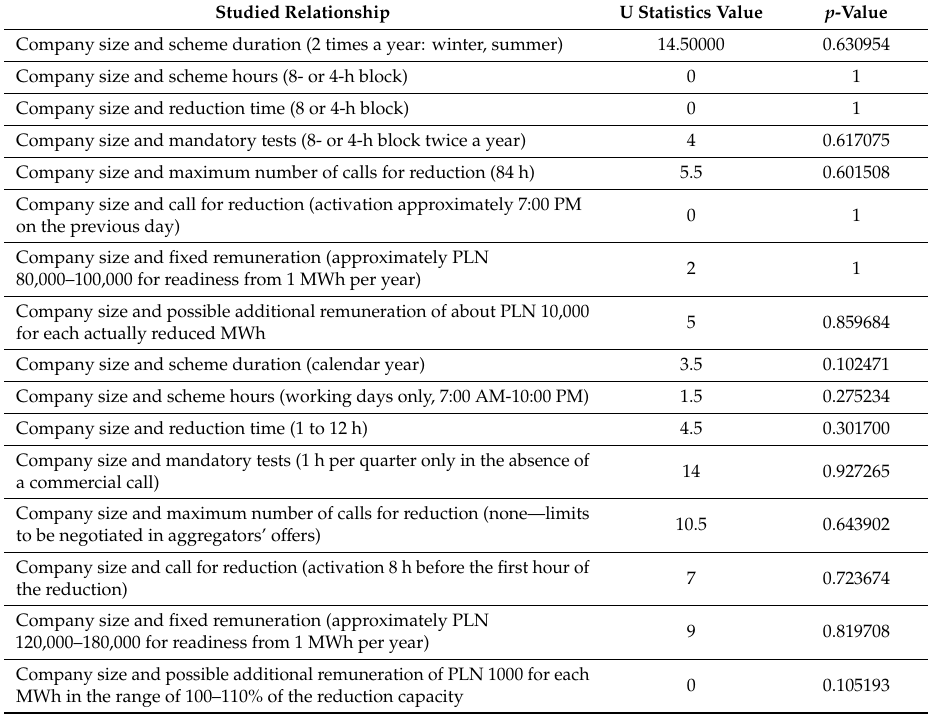
Table 6. Results of the Wilcoxon–Mann–Whitney test for companies divided into groups by size.